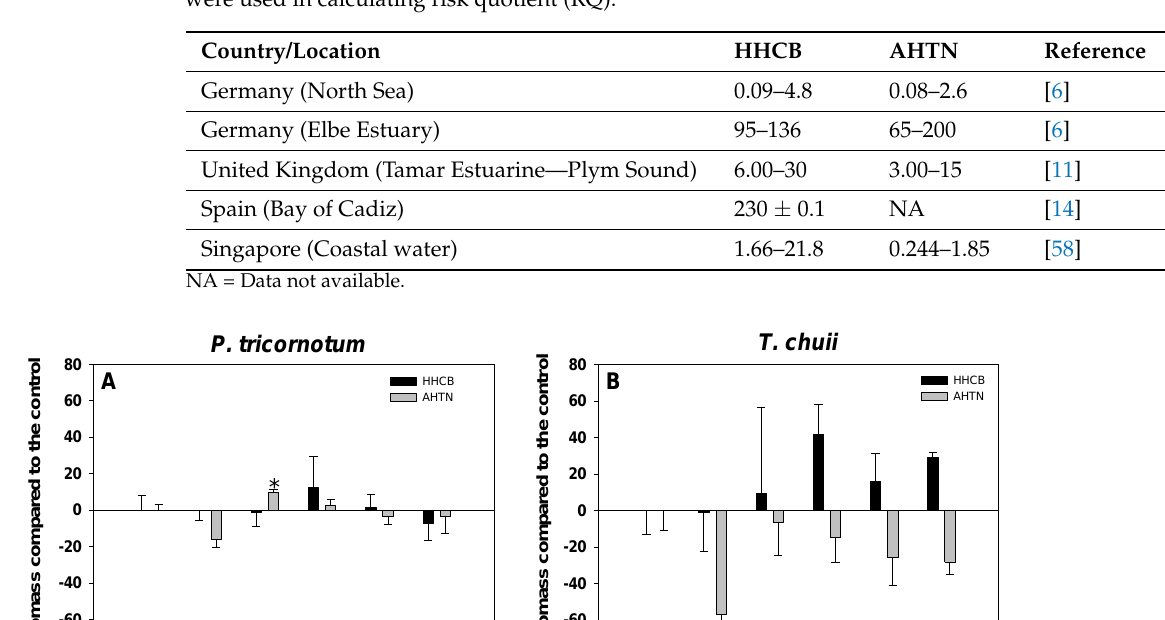
Table 1. Measured Environmental Concentrations (MEC) of Galaxolide (HHCB) and Tonalide (AHTN) in seawater from different locations. Measured values are in ng/L. Maximum values (bold) were used in calculating risk quotient (RQ).